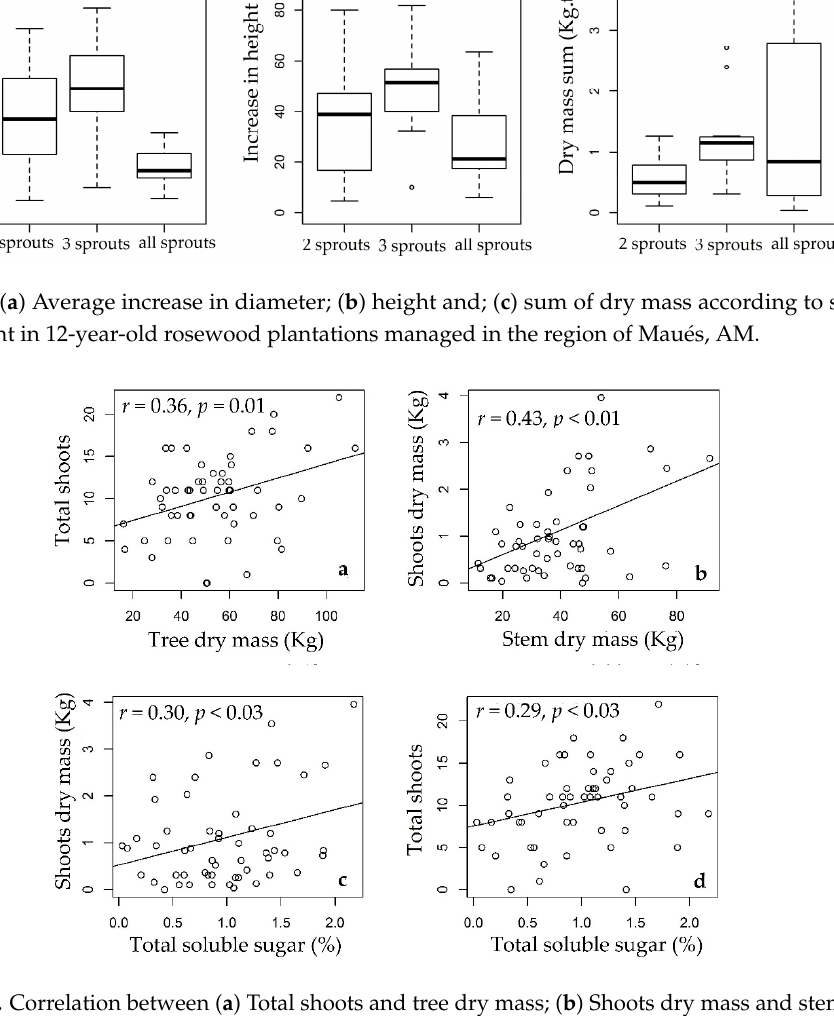
Figure A10. Correlation between ( a ) Total shoots and tree dry mass; ( b ) Shoots dry mass and stem dry mass; ( c ) Shoots dry mass and total soluble sugar; ( d ) total shoots and total soluble sugar in managed Central Amazonian rosewood plantations.